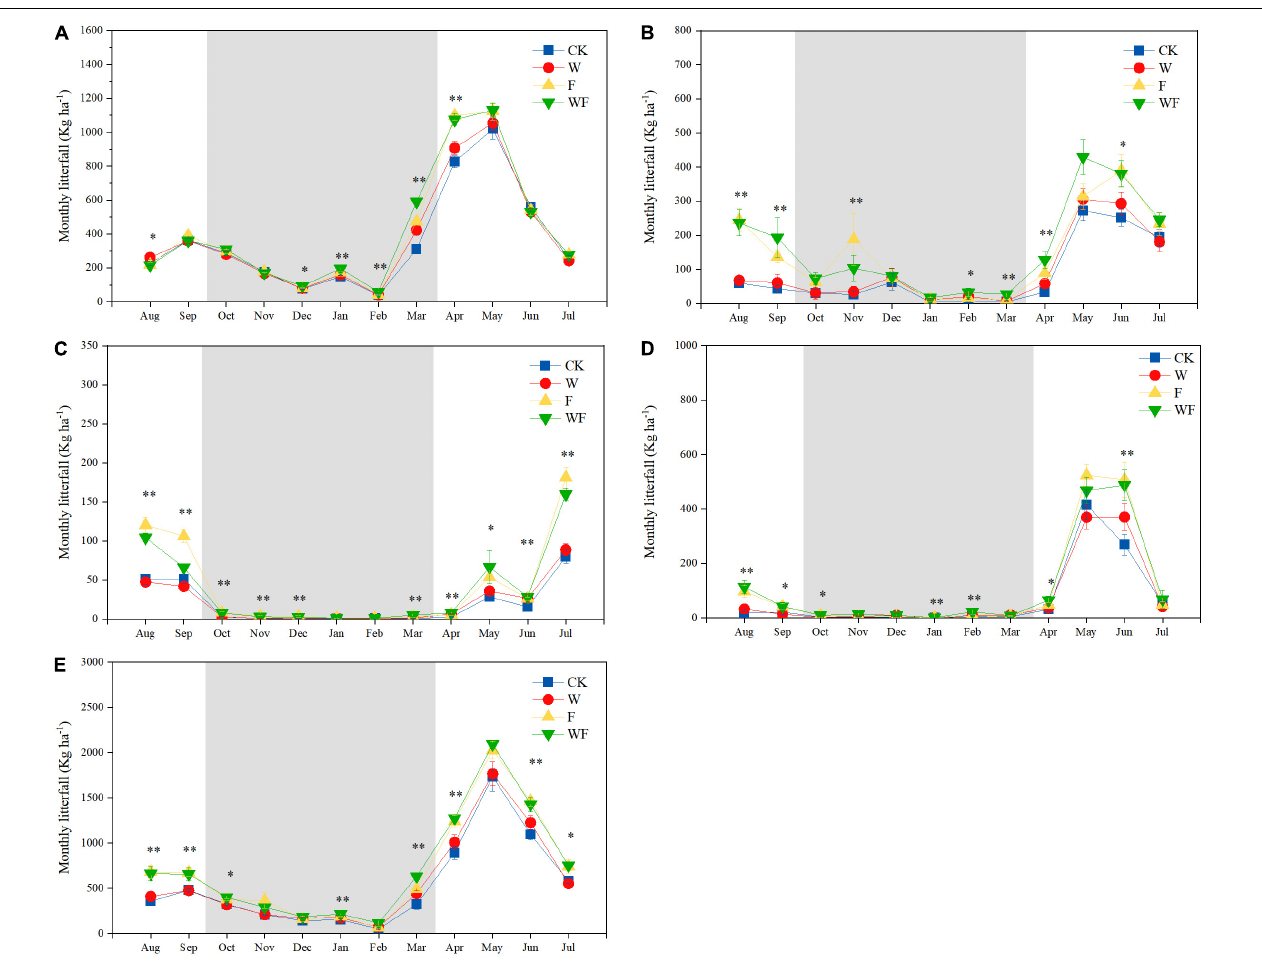
Figure 4 | Monthly leaf (A) , twig (B) , fruit (C) , bark (D) , and total (E) litter deposition of E. urophylla × E. grandis from August 2019 to July 2020. The gray areas represent the months in the dry season. The P-value showed the results from one-way ANOVA testing for the effects of dry-season irrigation and fertilization, ∗ P < 0.05, ∗∗ P < 0.01.